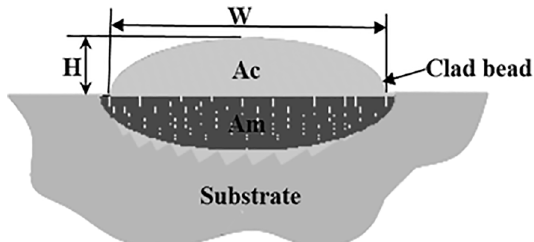
Figure 4. Schematic view of the cross-section of laser tracked deposit.